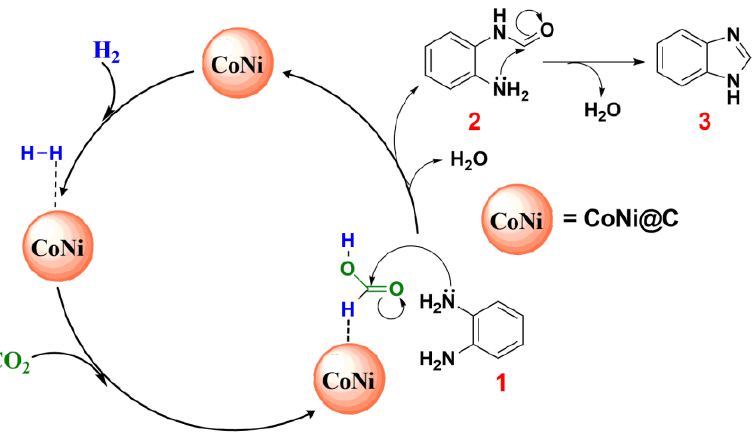
Figure 7. The plausible mechanism for benzimidazole formation catalyzed by CoNi@C.